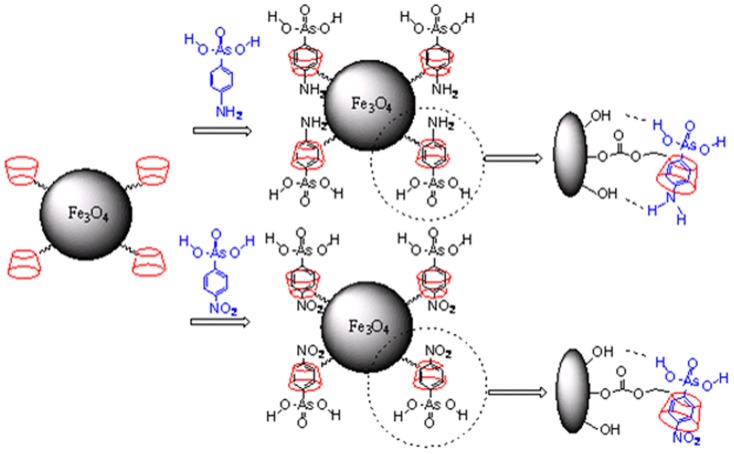
The likely interactions between CM-α-CD-Fe3O4 and the acids p-APAA and p-NPAA.